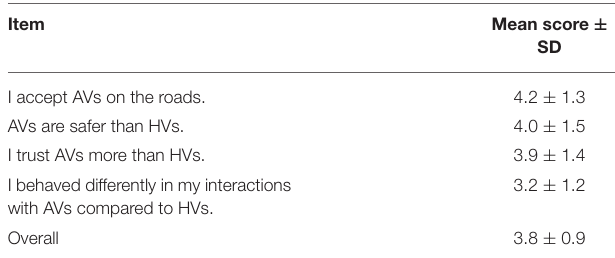
TABLE 1 | Results from the trust-related items of the post-experiment questionnaire. Item